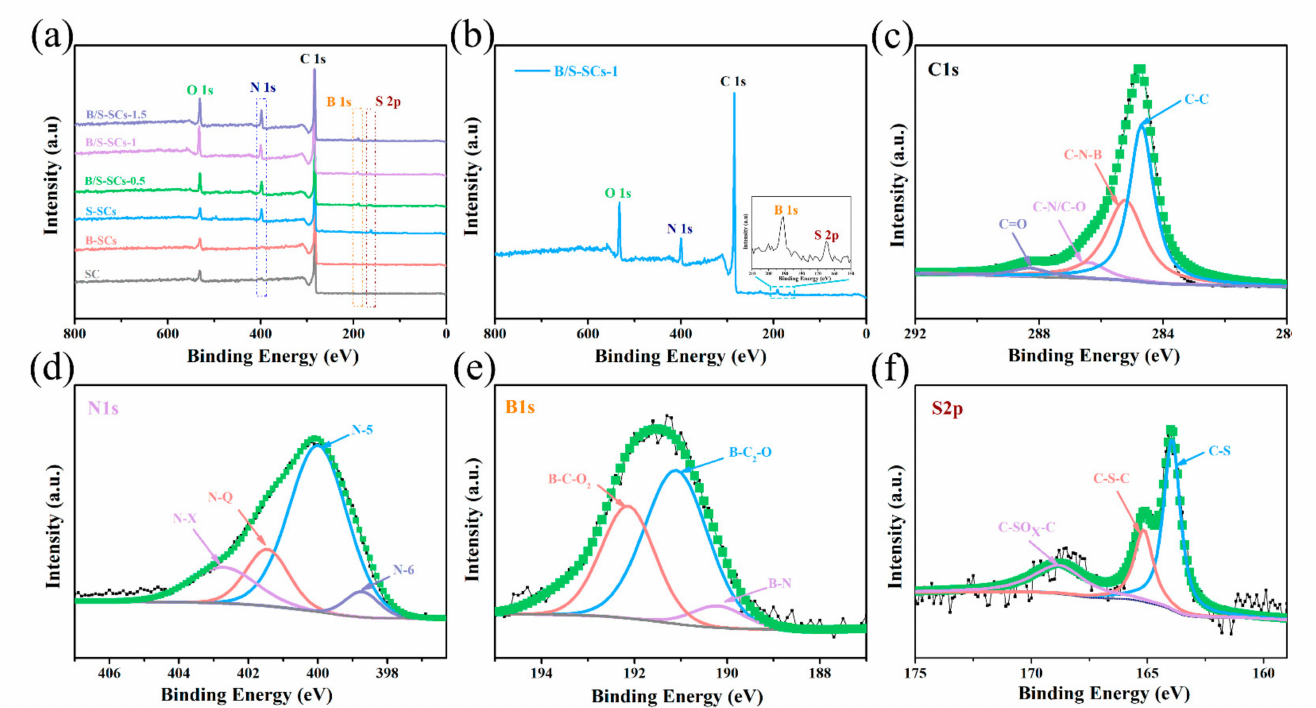
Figure 4. ( a ) XPS spectra of all samples; ( b ) XPS spectra of the B/S-SC S -1; ( c ) high-quality C 1s XPS images of B/S-SC S -1; ( d ) high-quality N 1s XPS images of B/S-SC S -1; ( e ) high-resolution B 1s XPS images of B/S-SC S -1; ( f ) high-quality S 2p XPS images of B/S-SC S -1.